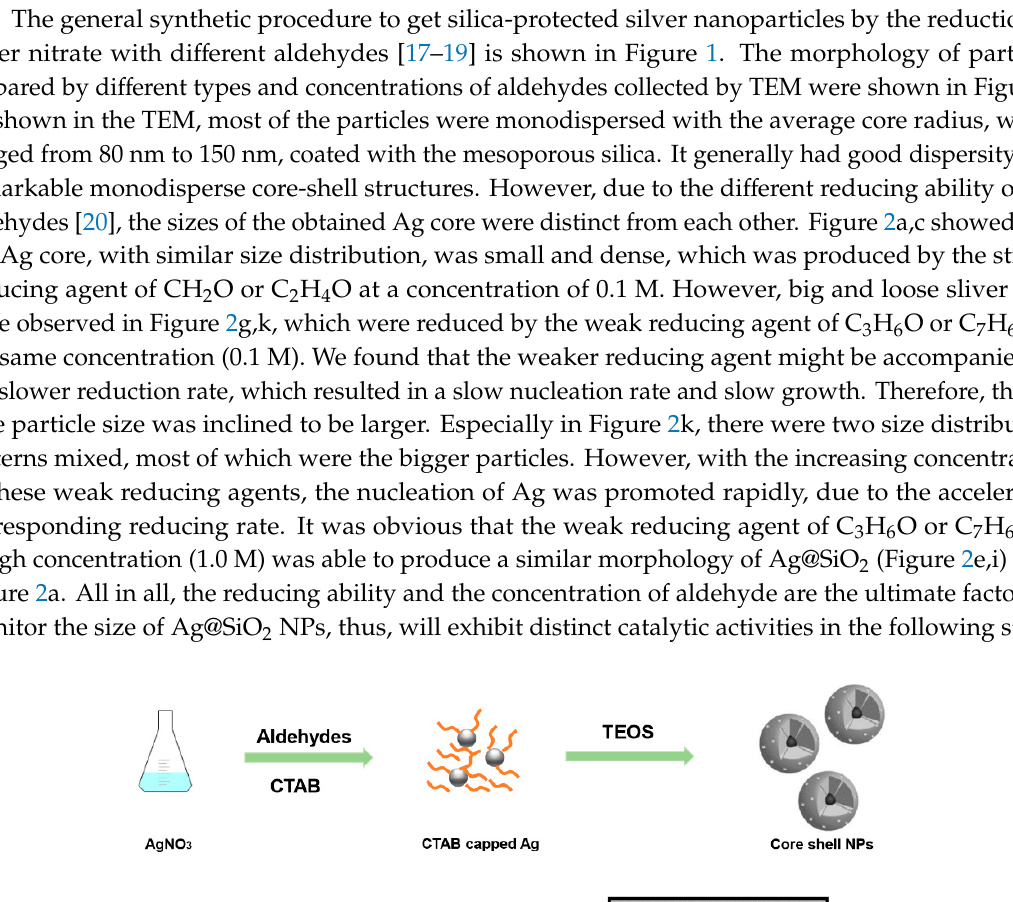
Figure 2. TEM images of Ag@SiO 2 nanoparticles prepared by CH 2 O before ( a ) and after ( b ), C 2 H 4 O before ( c ) and after ( d ), C 3 H 6 O (1.0 M) before ( e ) and after ( f ), C 3 H 6 O (0.1 M) before ( g ) and after ( h ), C 7 H 6 O (1.0 M) before ( i ) and after ( j ), and C 7 H 6 O (0.1 M) before ( k ) and after ( l ) nitrobenzene hydrogenation. It can be supported by the scanning electron microscopy images (Figure 3a) of the Ag core generated in a low-concentration benzaldehyde system without TEOS. The overall particle size was relatively large; even the smallest sphere in the picture was about 100 nm with small bud-shaped Ag that emerged on the surface. These bud-shaped Ag tended to grow continuously, which might have resulted in the maximum particle size being 300 nm. Figure 3b showed the generation of Ag cores in the formaldehyde system without TEOS. The overall morphology appeared to have a much smaller particle size and a spherical shape.